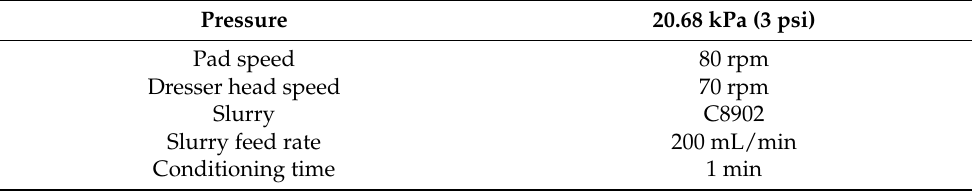
Table 4. Chemical mechanical planarization/polishing (CMP) parameters.